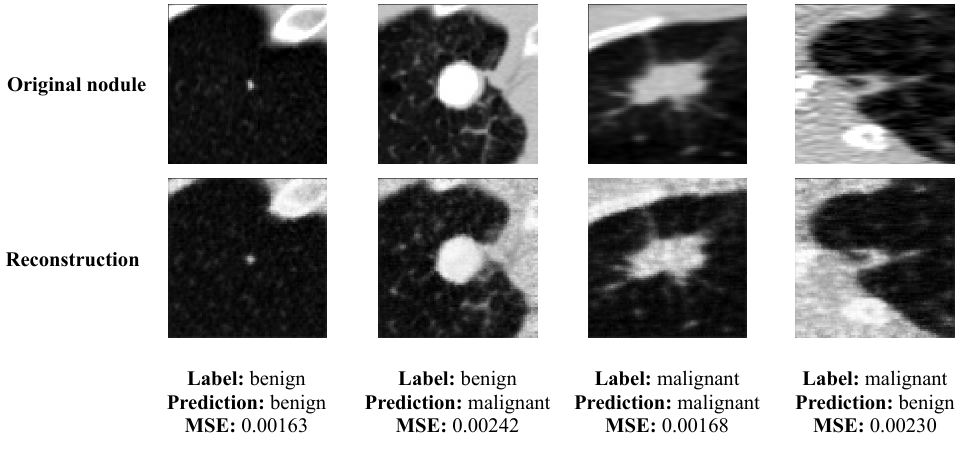
Figure 5. Testing examples, representing benign and malignant nodules, well and wrongly classified. The MSE value reported for each example represents the mean squared pixel error between the original image and its